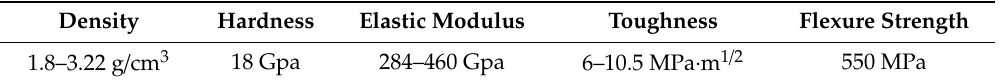
Table 1. The physical properties of Si 3 N 4 [20].